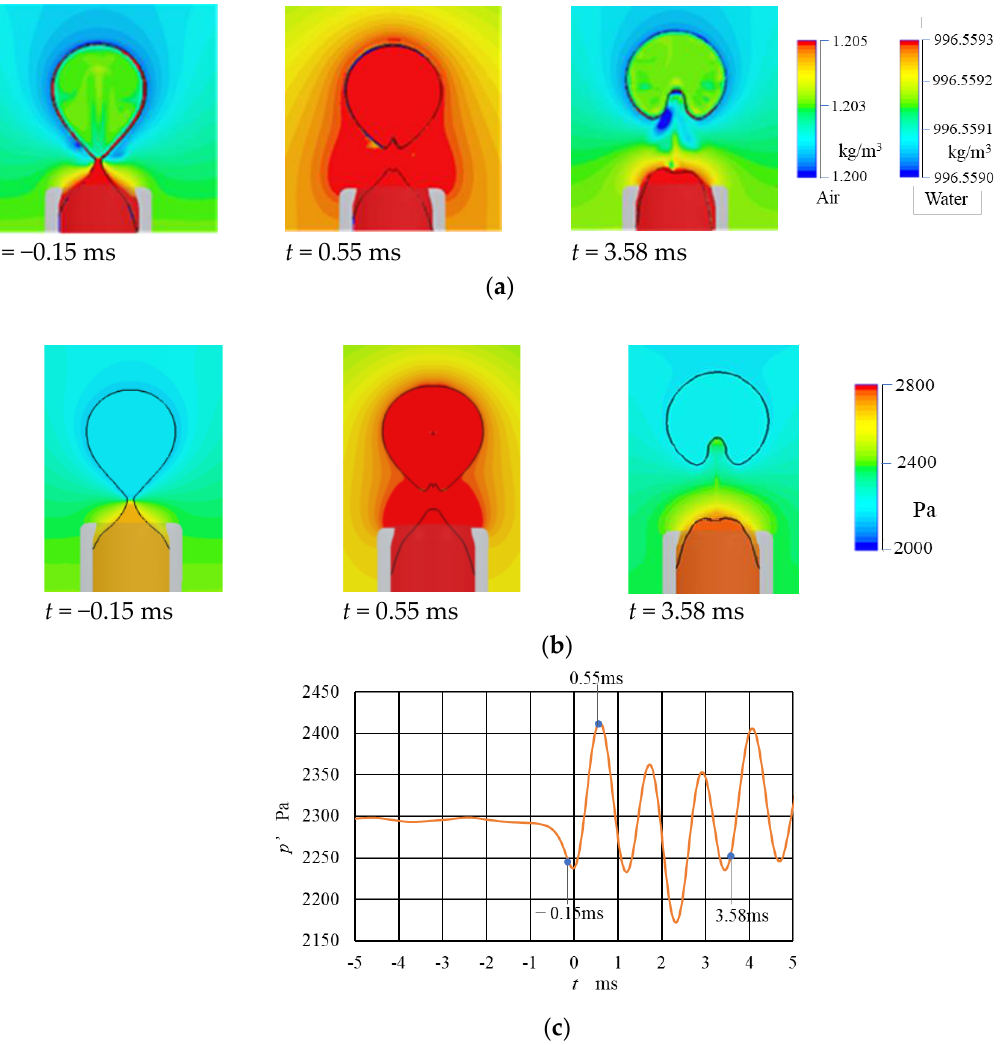
Figure 6. Density and pressure variation in computational fluid dynamics (CFD), φ = 6 mm. ( a ) Density of water and air bubble. ( b ) Pressure. ( c ) Data sampling timing on pressure diagram at measuring point. waist. The density and pressure decrease slightly relative to the initial state. After the